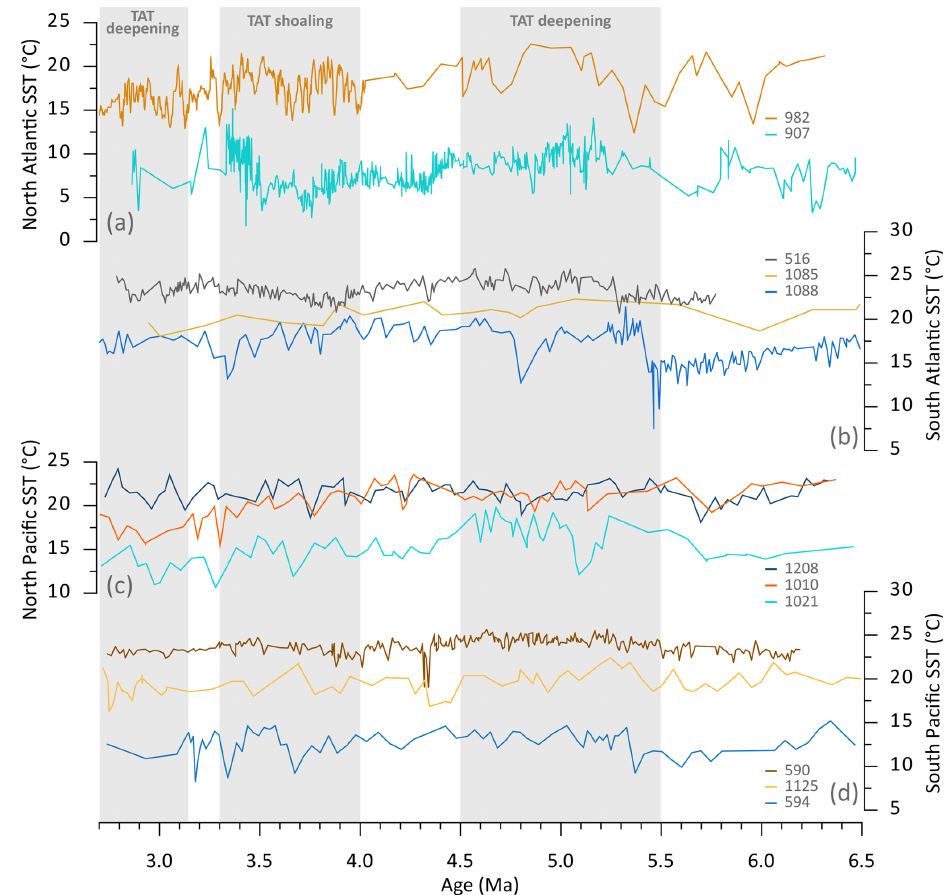
Figure 7. Regionally sorted midlatitude temperature records. (a) North Atlantic; (b) South Atlantic; (c) North Pacific; (d) South Atlantic. The records from Site 590 and 516 are Mg / Ca-based ( T. sacculifer ) from Karas et al. (2017); all other records are U k from the Herbert et al. (2016)